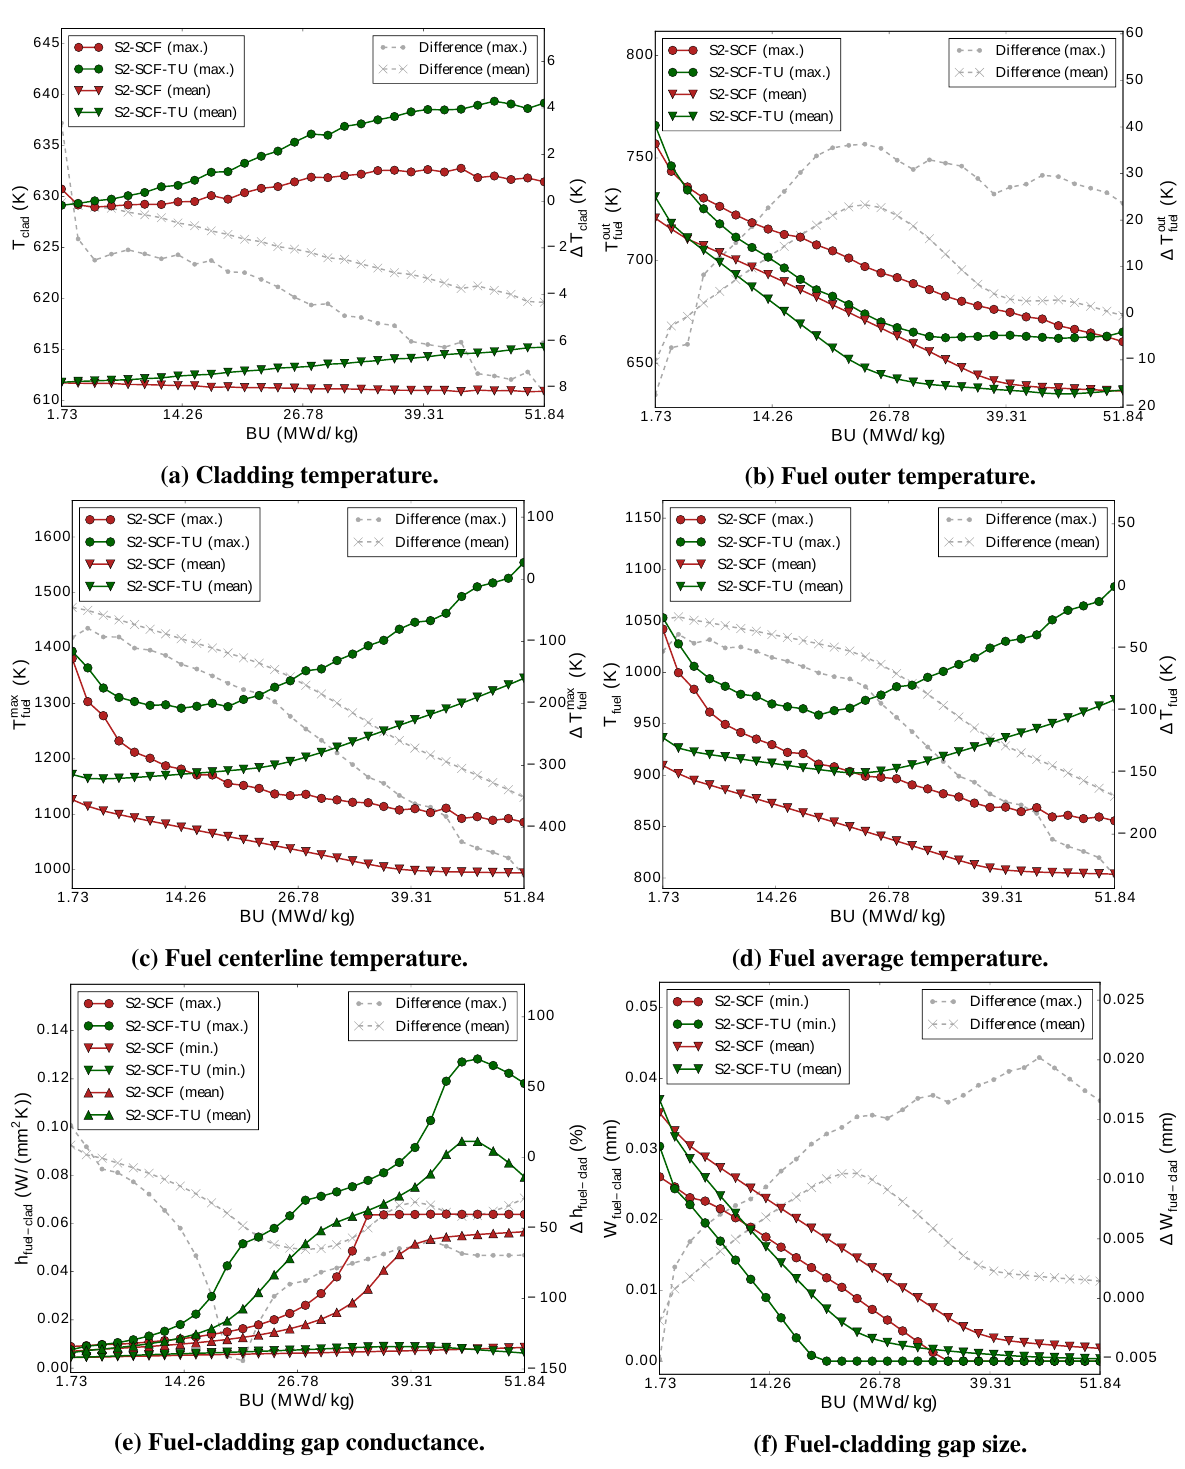
Figure 5: Fuel solution for Serpent2-SCF with and without